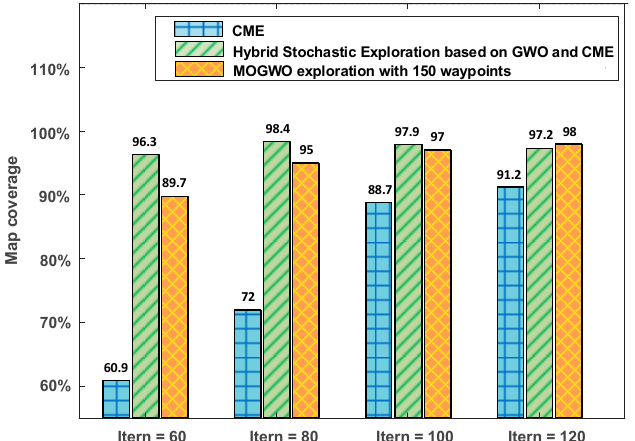
Figure 9. Comparison of three algorithms for the multi-robot exploration. The bars of the hybrid stochastic exploration algorithm based on GWO and coordinated multi-robot exploration (CME) are average values of 30 simulation-runs. The bars of the MOGWO exploration algorithm are average values taken from the row corresponding to 150 waypoints in Table 2.